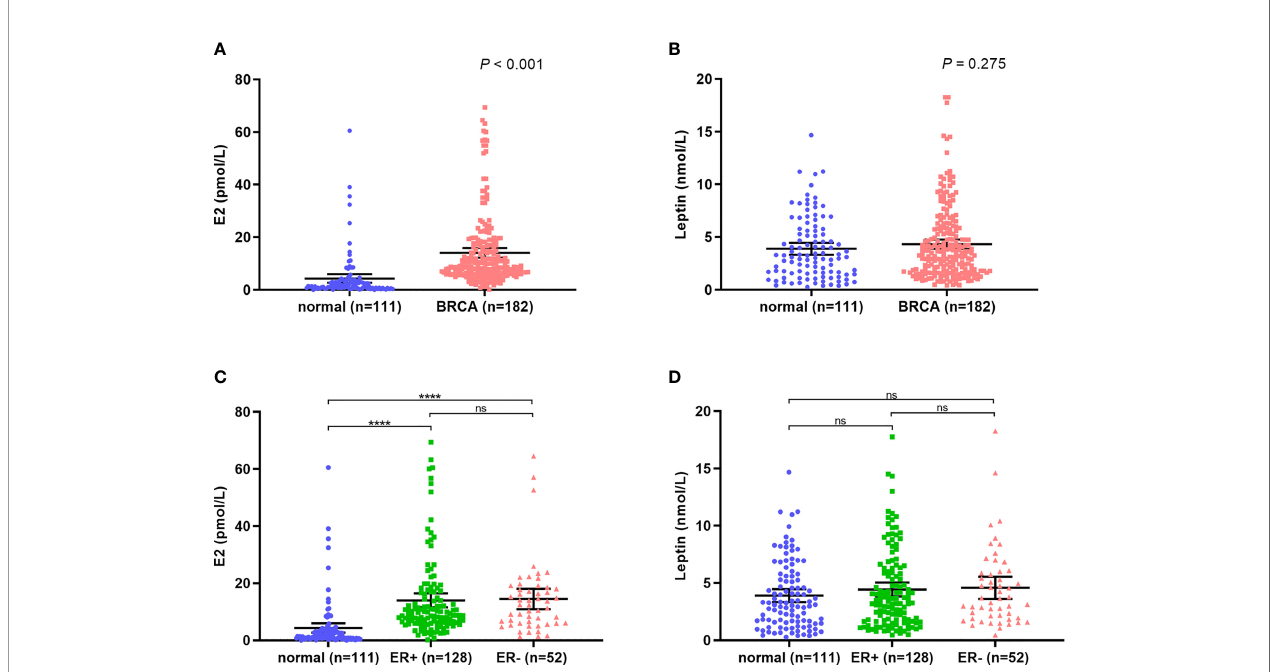
FIGURE 1 | E2 and leptin levels in breast cancer patients and normal subjects. (A) High level of E2 in breast cancer patients compared with normal subjects; (B) The level of leptin showed no signi fi cant difference between breast cancer patients and normal subjects; (C, D) The levels of E2 and leptin are independent of ER expression. **** P < 0.0001; ns, P >